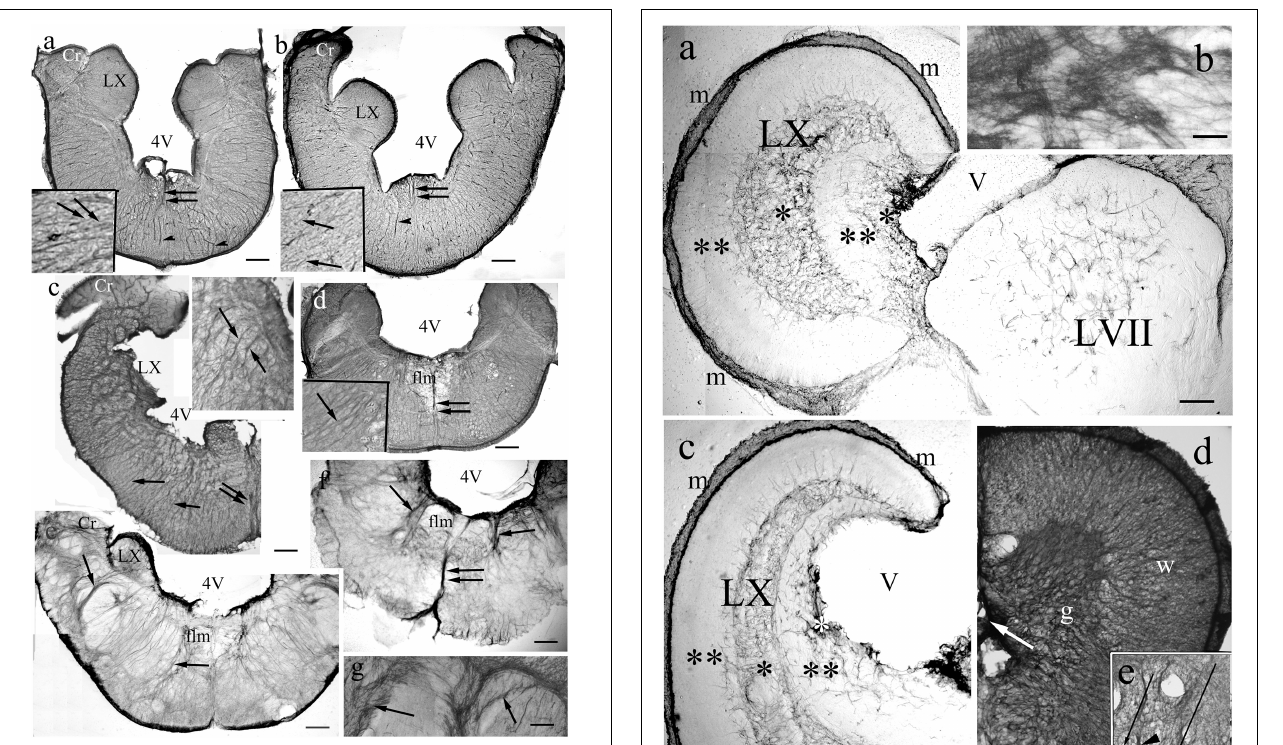
FIGURE 13 | Medulla. 4V: 4th ventricle, its thin roof has not been preserved during sectioning, Cr: crista cerebelli, flm: medial longitudinal fascicle, LX: vagal lobe, arrows: glial processes. double arrows: thick midline glial bundle, arrowheads: vessels. (For orientation also see Figure 11d ). (a) Bichir. Dense, rather regular radial process system. Scale bar: 120 µ m, for the inset 40 µ m. (b) Sterlet. Dense, rather regular radial process system. Scale bar: 150 µ m, for the inset 50 µ m. (c) Gar. The radial processes are going to be pushed away by myelinated axon groups (light spots). The vagal lobe is damaged. Scale bar: 150 µ m, for the inset 50 µ m. (d) Butterfly fish. The radial processes are going to be pushed away by myelinated axon groups. Scale bar: 200 µ m, for the inset 50 µ m. (e) Eel. The radial system is less regular, the processes separate (arrows) myelinated axon bundles. Scale bar: 200 µ m. (f) Beam. The radial system is less regular, the processes separate (arrows) myelinated axon bundles. Scale bar: 200 µ m. (g) A detail of a carp brain stem. Thick bundles of myelinated axons surrounded with glial processes (arrows). Scale bar: 100 µ m.